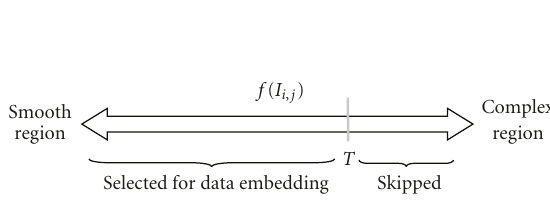
Figure 5: The image of prediction errors.